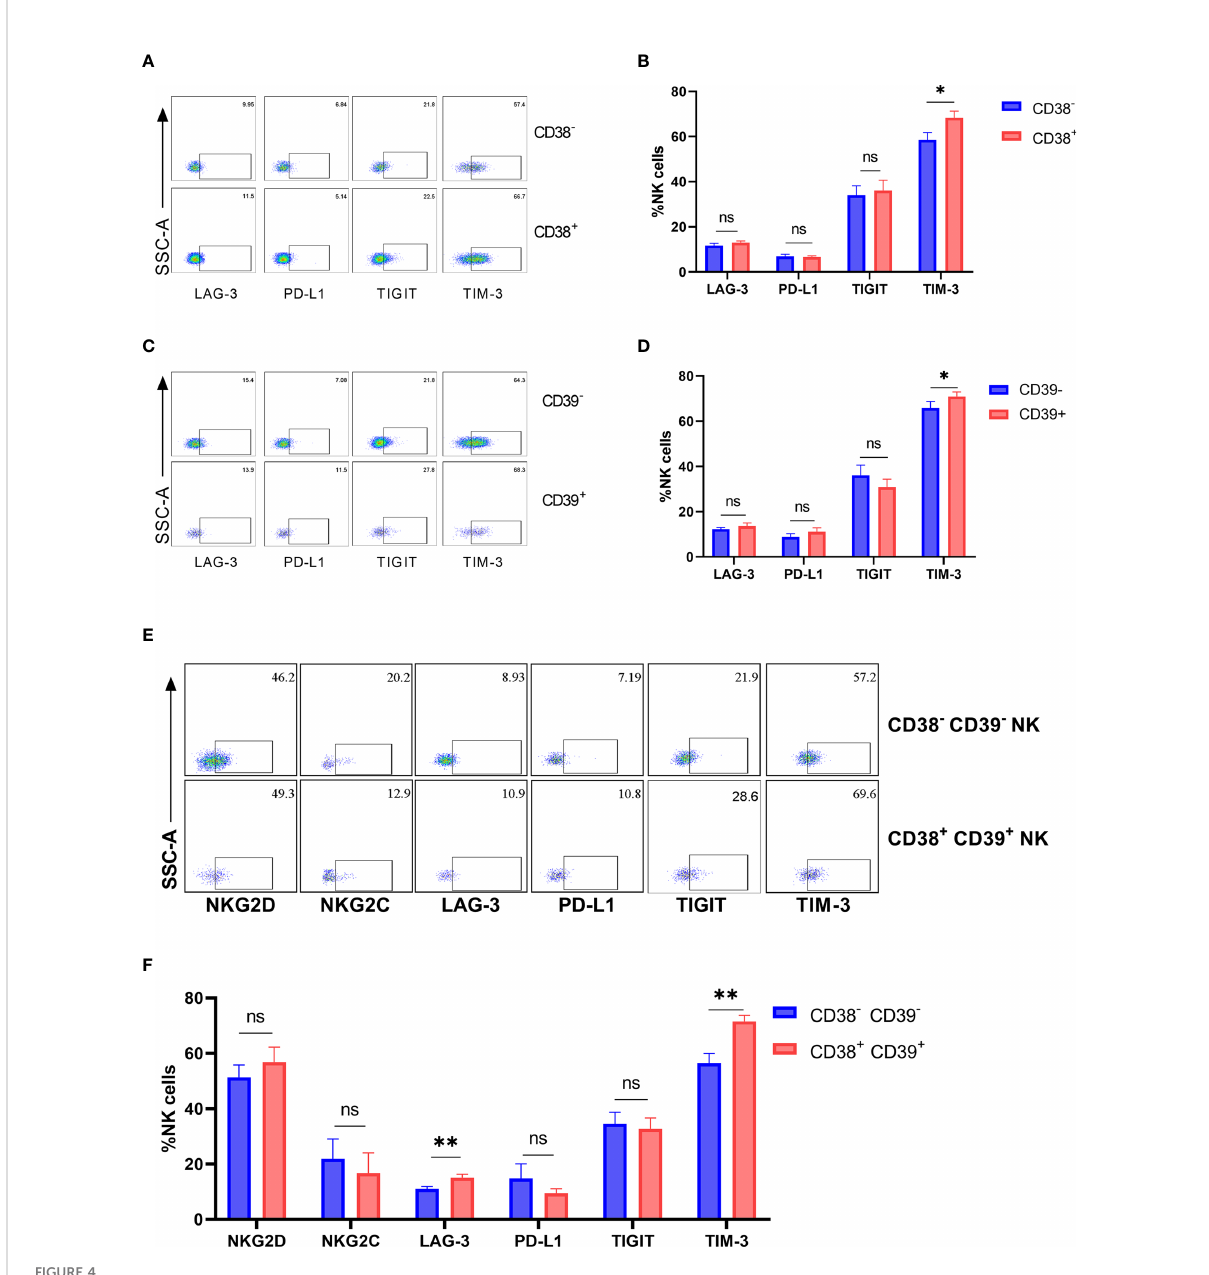
FIGURE 4 The expression of inhibitory receptors increased on CD38+ or/and CD39+ NK cells. (A) The representative fl ow cytometry plots of LAG-3, PD- L1, TIGIT, and TIM-3 on CD38 - and CD38 + NK cells. (B) Comparison of the expression of LAG-3, PD-L1, TIGIT, and TIM-3 between CD38 - and CD38 + NK cells. (C) The representative fl ow cytometry plots of LAG-3, PD-L1, TIGIT, and TIM-3 on CD39 - and CD39 + NK cells. (D) Comparison of the expression of LAG-3, PD-L1, TIGIT, and TIM-3 between CD39 - and CD39 + NK cells. (E) The representative fl ow cytometry plots of NKG2D, NKG2C, LAG-3, PD-L1, TIGIT, and TIM-3 on CD38 - CD39 - and CD38 + CD39 + NK cells. (F) Comparison of the expression of NKG2D, NKG2C, LAG-3, PD-L1, TIGIT, and TIM-3 on CD38 - CD39 - and CD38 + CD39 + NK cells. *p < 0.05, **p < 0.01, ns: no signi fi